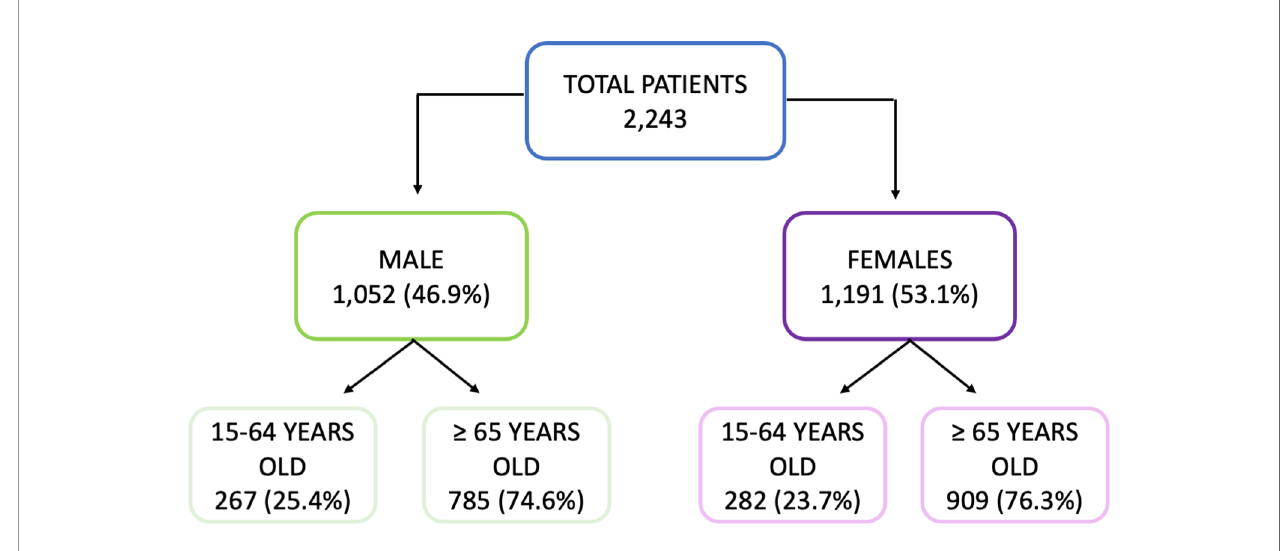
FIGURE 1 | Diagram of the cohort